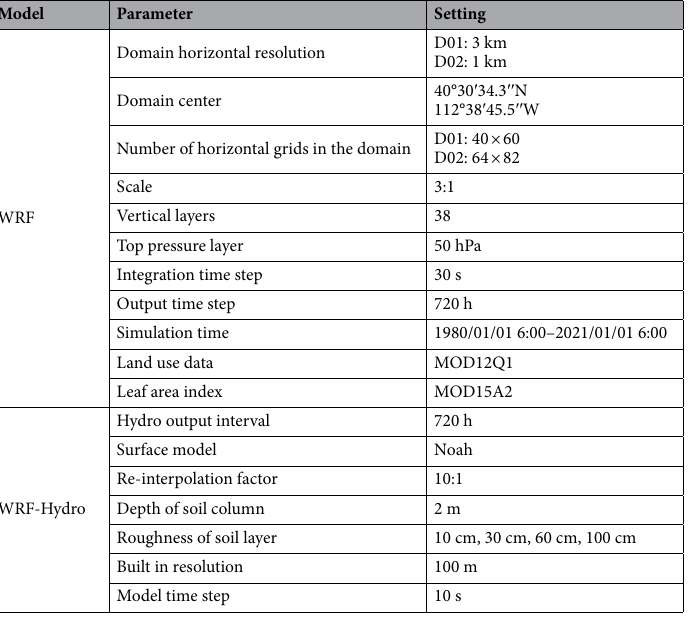
Table 1. Basic parameter settings of WRF and WRF-Hydro.